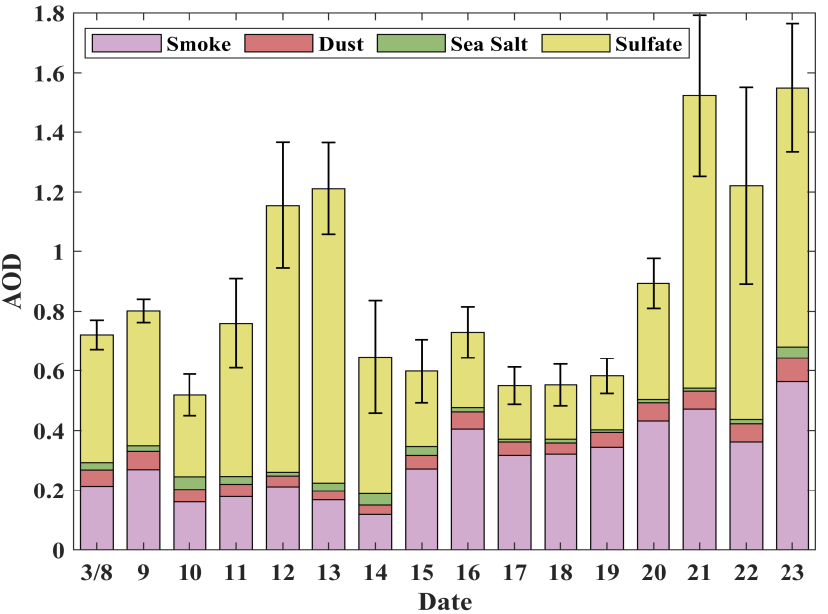
Figure 11. Daily variations of AOD for smoke, dust, sea salt and sulfate aerosols from 8 to 23 March 2021.